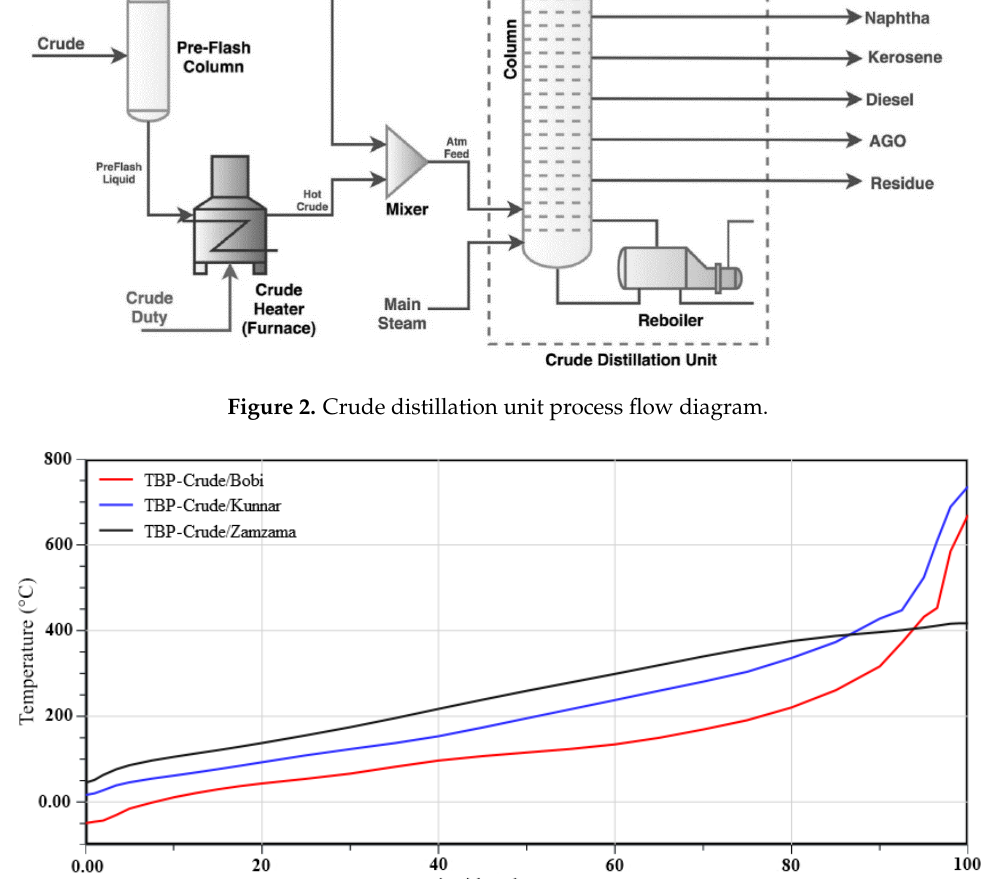
Figure 2. Crude distillation unit process flow diagram . Table 1. Specifications of Pakistani Crudes: Bobi, Kunnar and Zamzama.